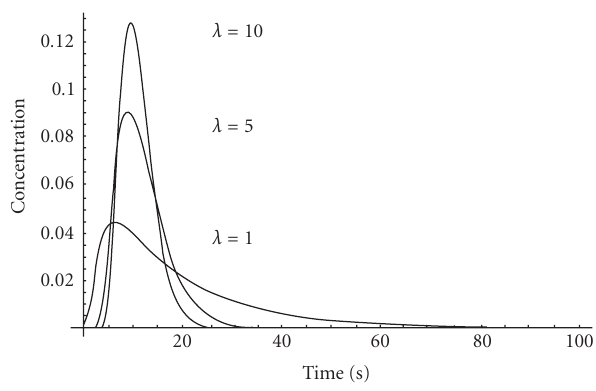
Figure 2: Examples of LDRW curves with di ff erent λ ( γ = 10 and m/q =